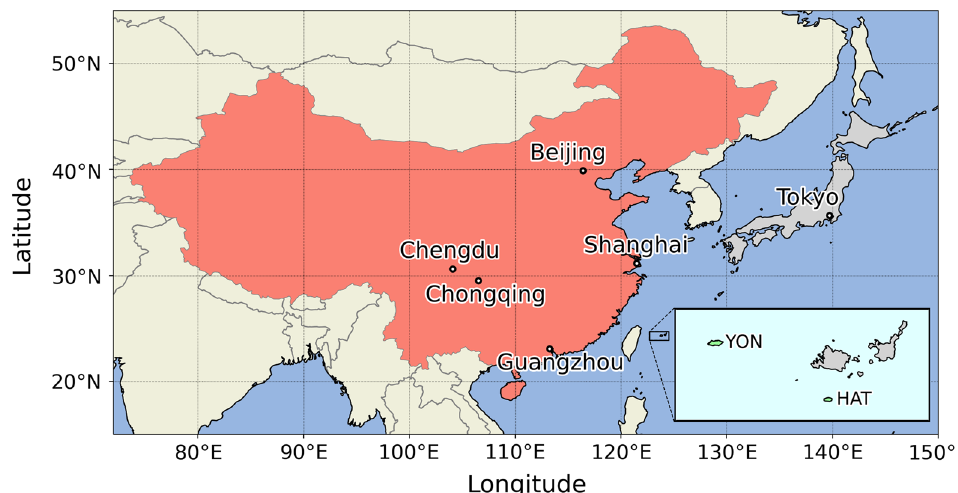
Fig. 1 Map showing the locations of Hateruma Island (HAT) and Yonaguni Island